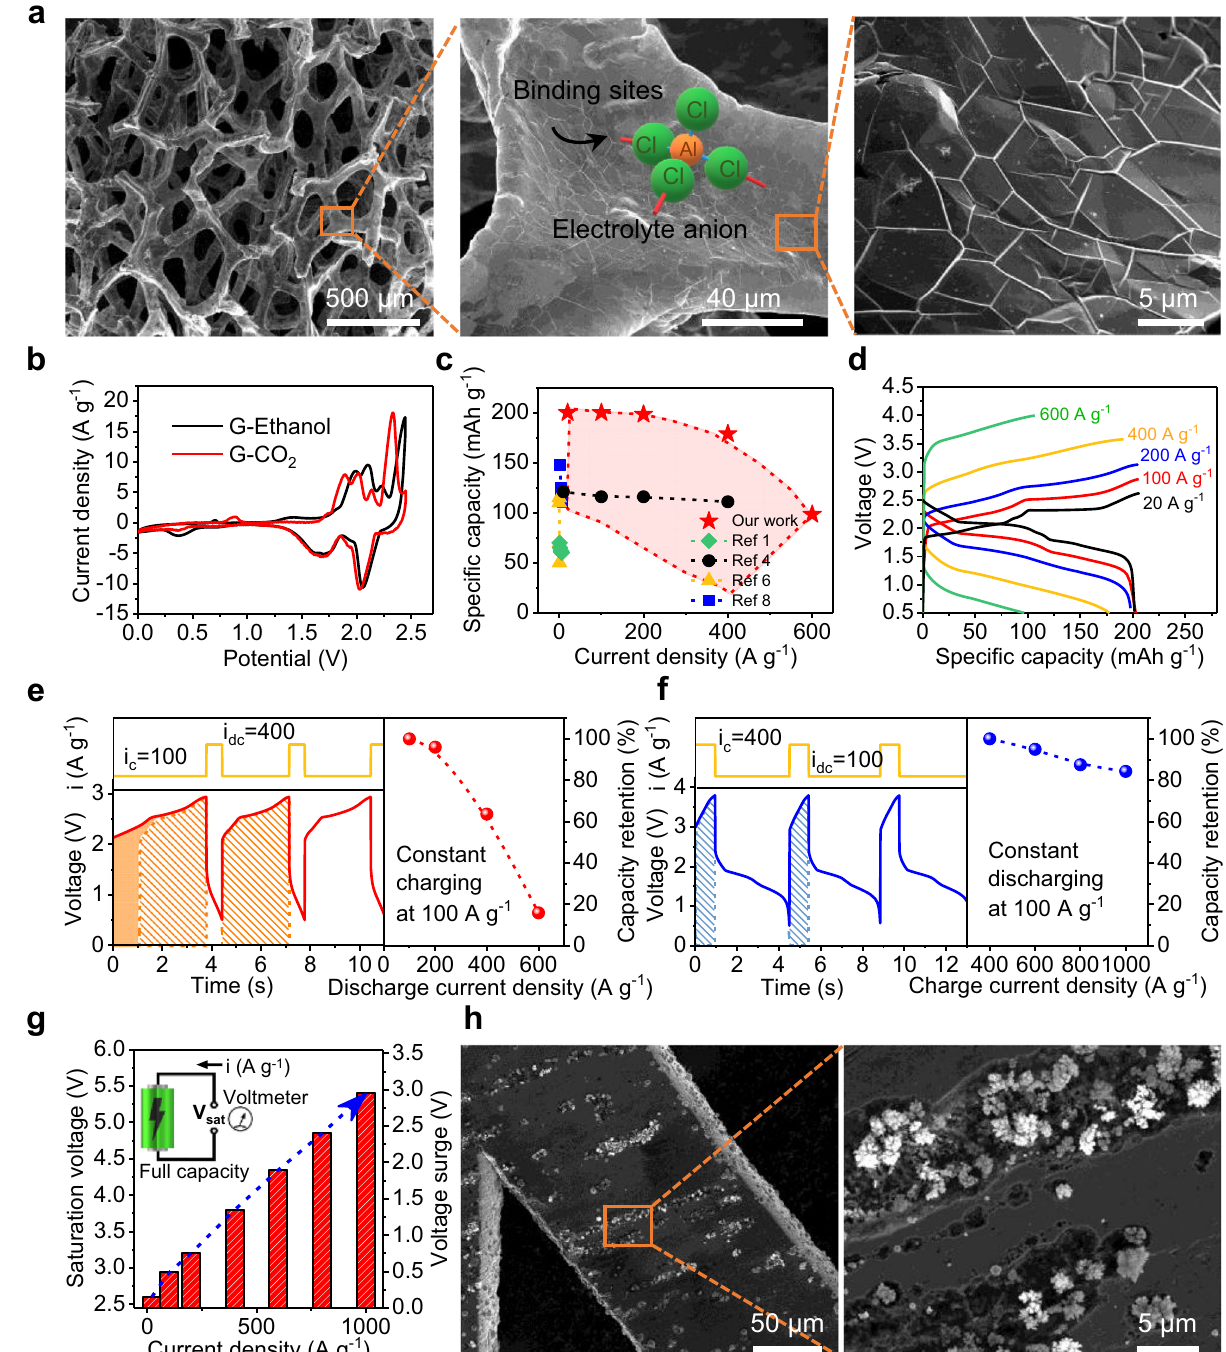
Fig. 1 Highlights of Al-ion batteries and their performance limits. a Scanning electron microscopy (SEM) images of a three-dimensional graphene network after supercritical CO 2 drying. Large open pores with interconnecting frameworks are clearly visible. b Cyclic voltammograms of graphene that was either supercritical CO 2 dried (G-CO 2 ) or dried by evaporating ethanol (G-Ethanol) (scan rate of 10 mVs − 1 ). c Plot of the speci fi c capacity versus current density for our work (entire red block) and state-of-the-art. d Galvanostatic charge and discharge curves for devices having record-high speci fi c capacities (200 mAh g − 1 ). The graphene cathode has a mass of 0.013 mg and density of 0.16 mg cm − 2 . e Fast discharge ( i c = 100 A g − 1 , i dc = 100 ~ 600 A g − 1 ) leads to a quick drop in speci fi c capacity (area of the shadow to assist the view on the amount of charging capacity). f Moderate discharge followed after a fast charge ( i c = 400 ~ 1,000 A g − 1 , i dc = 100 A g − 1 ) retains 85% speci fi c capacity even when batteries were charged at 1000 A g − 1 . g Charging voltage to maintain a decent speci fi c capacity goes up quickly with the increase of current density. h SEM images of spotted Al islands inside surface pits of a pure Al anode after battery cells were fully charged at 400 A g − 1